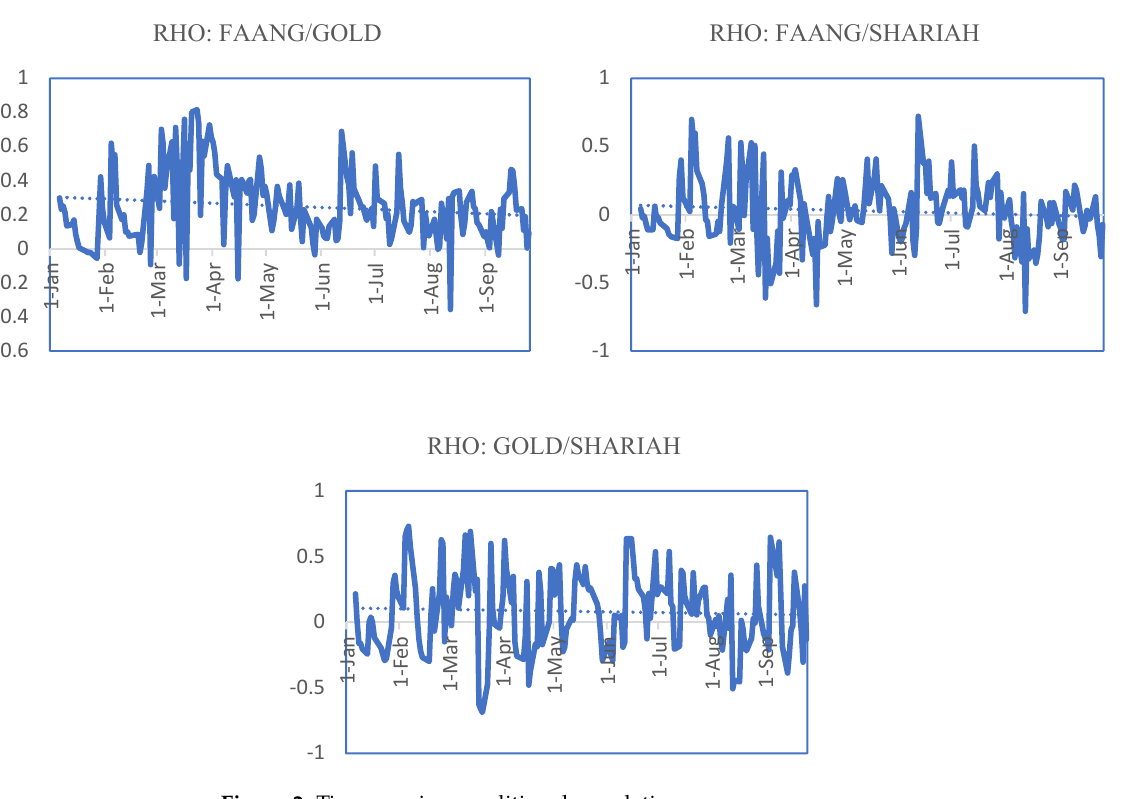
Figure 2. Time-varying conditional correlations. Table 3. Static and dynamic conditional correlations. Panel A: Static correlations FAANG Panel B: Dynamic conditional correlations- DCC framework